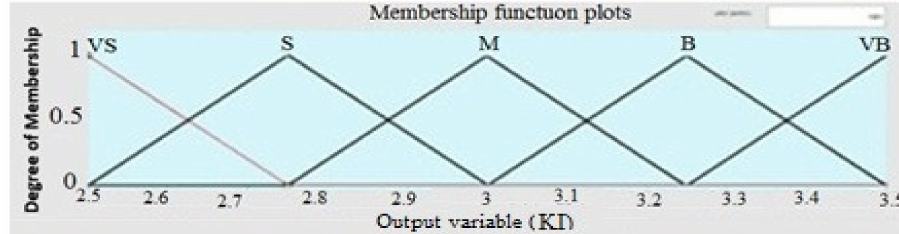
Figure 5. Proportional gain membership function (KP).